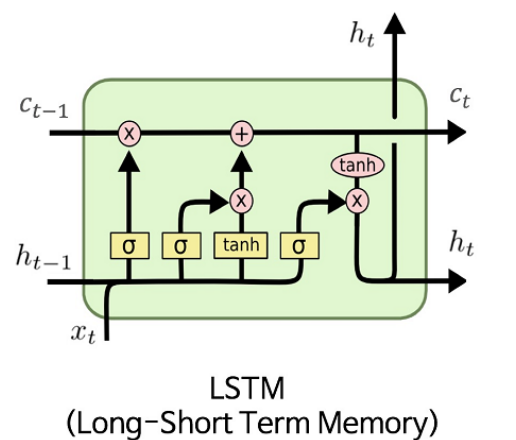
Figure 9. The structure of an LSTM block used to process longitudinal data and distributed under a CC BY-SA 4.0